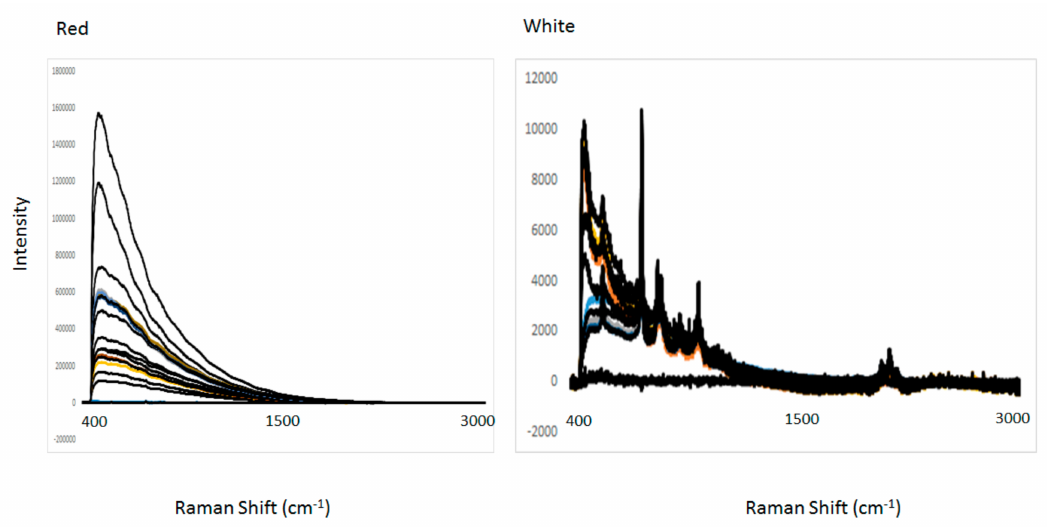
Figure 1. Typical spectra of red and white wine samples sourced from di ff erent varieties and regions and analyzed using Raman spectroscopy.